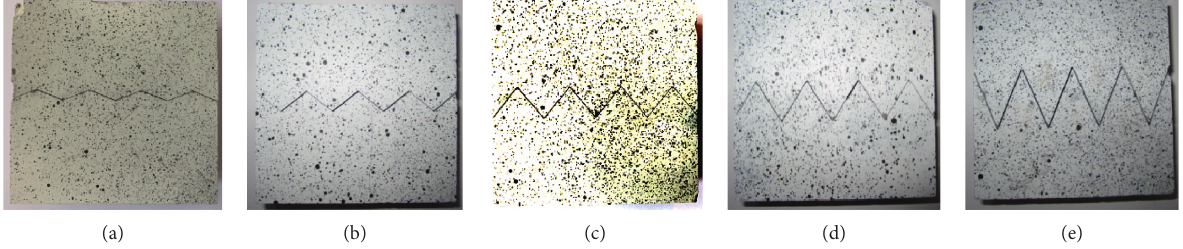
Figure 2: Specimens with different undulating heights. (a) B-5. (b) B-10. (c) B-15. (d) B-20. (e) B-30.